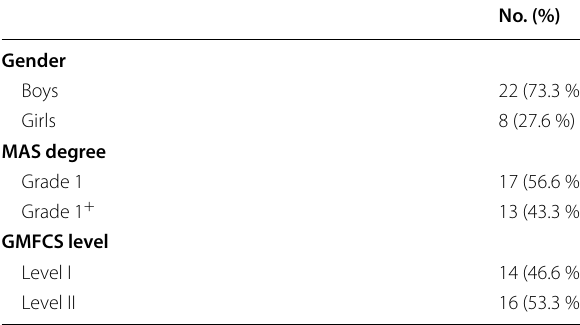
Table 2 Frequency distribution of gender, MAS, and GMFCS among studied children